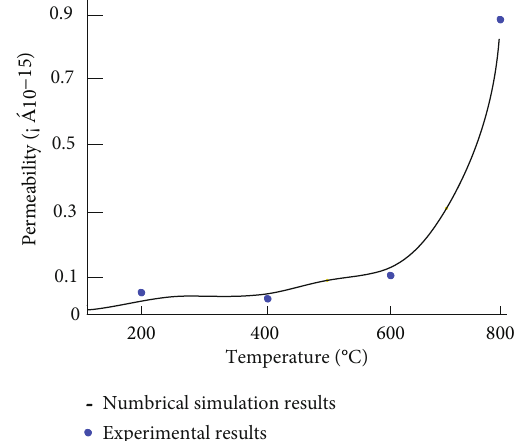
Figure 6: Coal penetration value at di ff erent